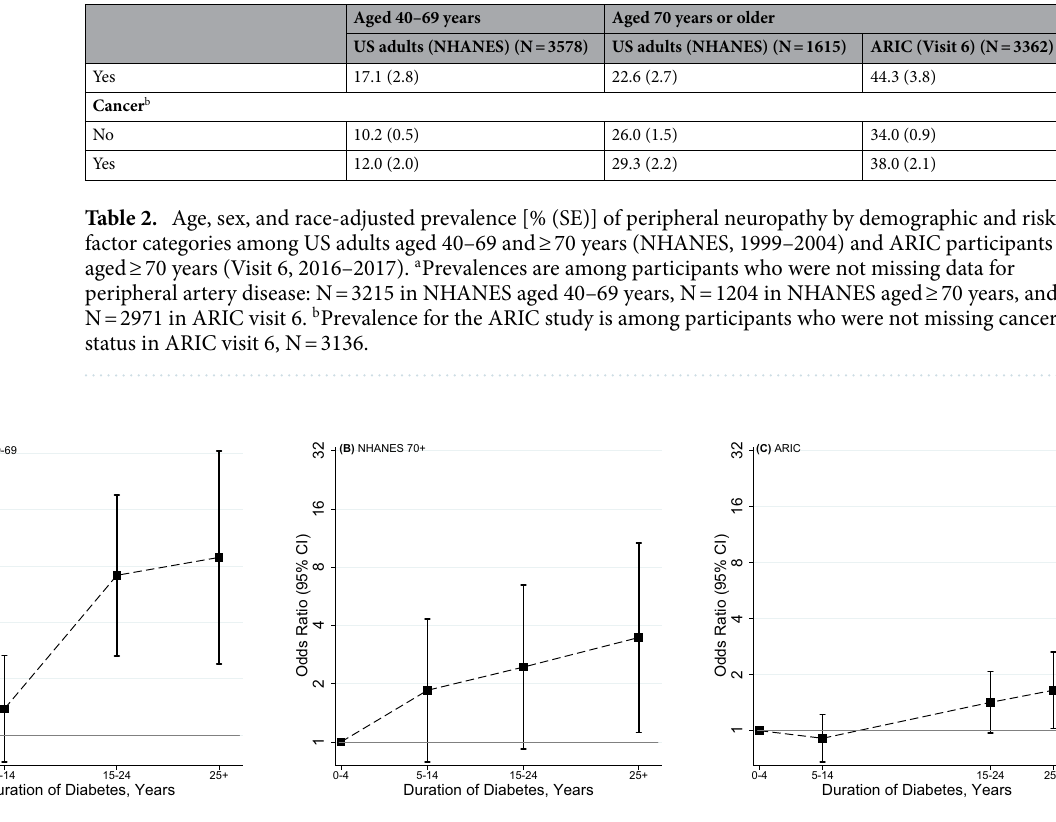
Figure 2. Association of peripheral neuropathy with duration of diabetes among US adults aged 40–69 (panel A ) and ≥ 70 years (panel B ) (NHANES, 1999–2004) and ARIC participants aged ≥ 70 years (panel C ) (Visit 6, 2016–2017). Adjusted associations for duration of diabetes with peripheral neuropathy in ARIC (2016–2017) and NHANES (1999–2004).Odds ratios were from logistic regression models adjusted for age, sex and race. Duration of diabetes was modelled as a categorical variable: 0–4 years, 5–14 years, 15–24 years and 25 years and more. Odds ratios and 95% confidence intervals were plotted at the median of each diabetes duration